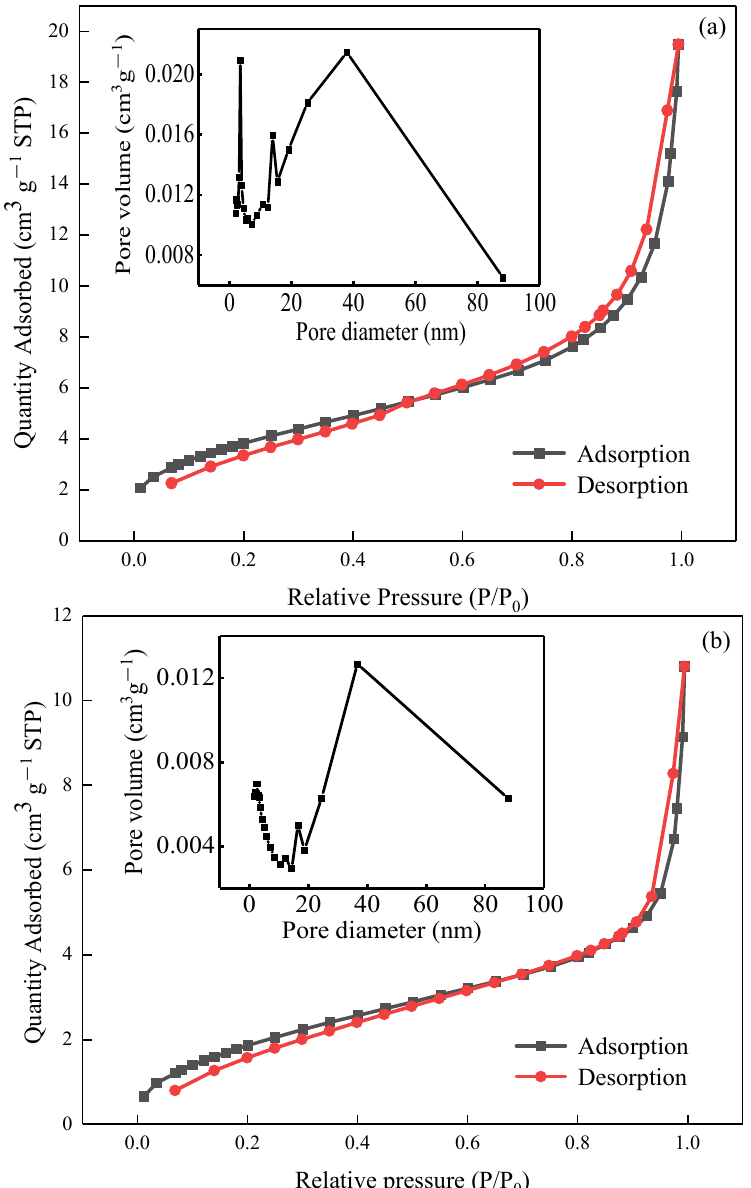
Figure 5. Nitrogen adsorption/desorption isotherms of DA ( a ) and DA/ β -CD ( b ), insets are corre- sponding pore size distribution.